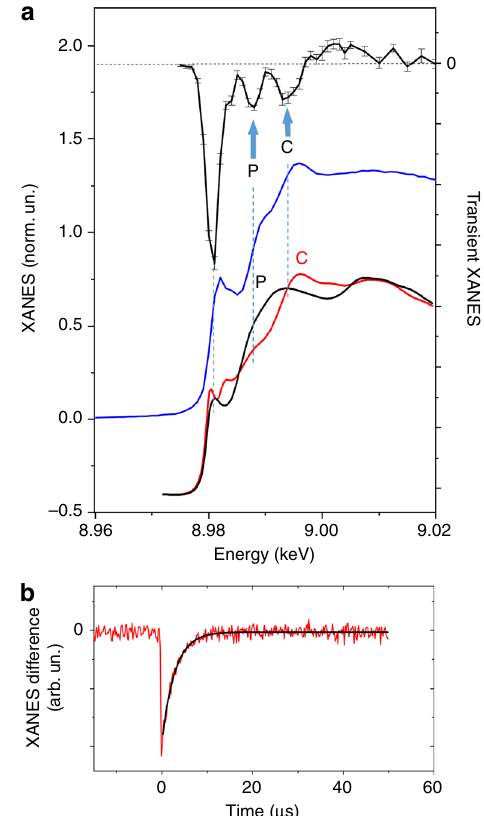
Fig. 2 Pump-probe Cu K-edge X-ray absorption of [Cu 4 ( PCP ) 3 ] + . a Experimental Cu K-edge transient X-ray absorption difference spectrum corresponding to the transition to the triplet excited state of [Cu 4 ( PCP ) 3 ] + (1 µ s time window after the photoexcitation) (black line with error bars (standard error of mean)), experimental ground state spectrum (blue line), theoretical ground state spectra corresponding to P-coordinated Cu atoms (black line) and C-coordinated Cu atoms (red line). b Kinetics measured using transient XAS for the incident beam energy 8.980 keV (red line) and exponential fi t of these data (black